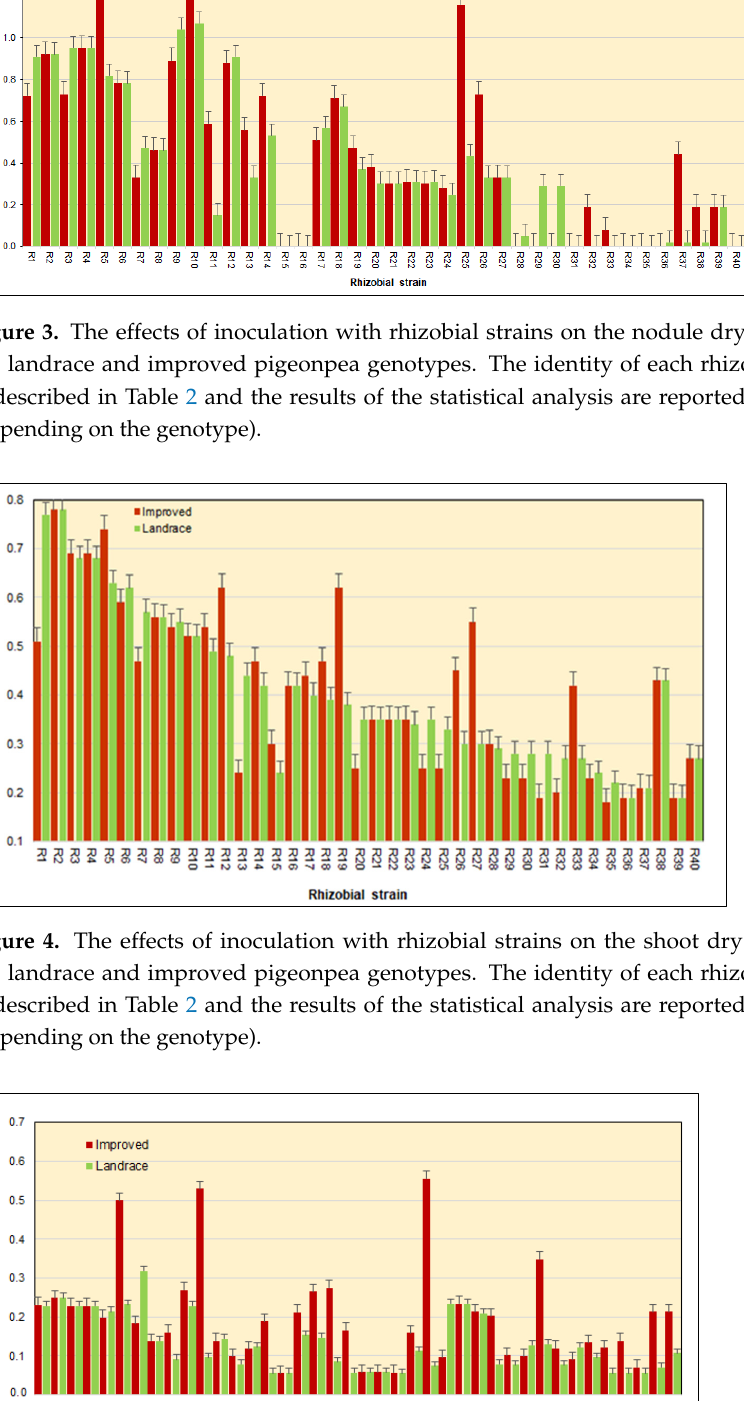
Figure 5. The effects of inoculation with rhizobial strains on the root dry weight per plant of the landrace and improved pigeonpea genotypes. The identity of each rhizobial strain (R1–R40) is de- scribed in Table